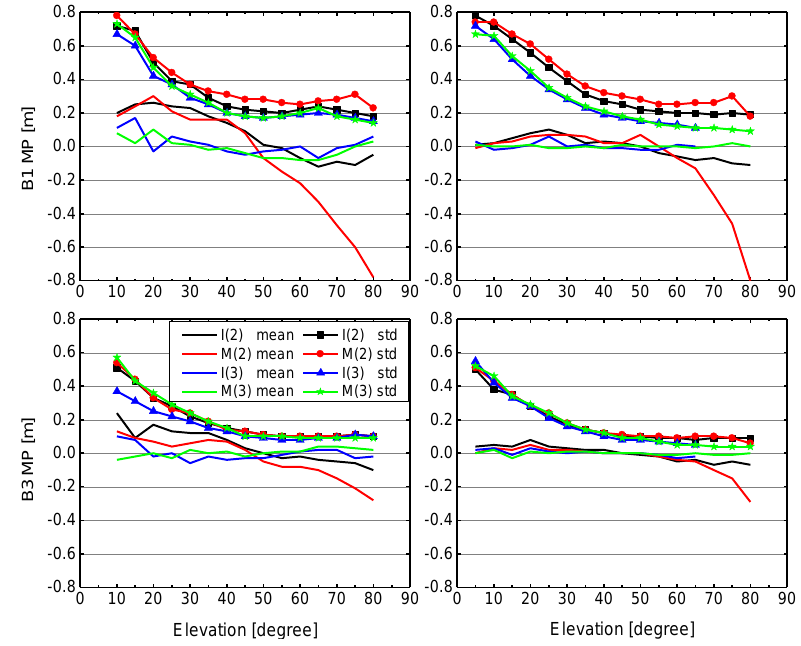
Figure 6. Mean and standard deviation (std) of MP combinations as a function of elevation for BDS-2 and BDS-3 IGSO and MEO satellites signals at stations BJF1 (left) and KUNU (right) during DOY 204-221, 2016. The upper and bottom panels show the results for B1 and B3, respectively. I(2) and M(2) represent BDS-2 IGSO (C06, C07, C08, C09, C10) and MEO (C11, C12, C14) satellites, and I(3) and M(3) represent BDS-3 IGSO (C31, C32) and MEO (C33, C34) satellites.